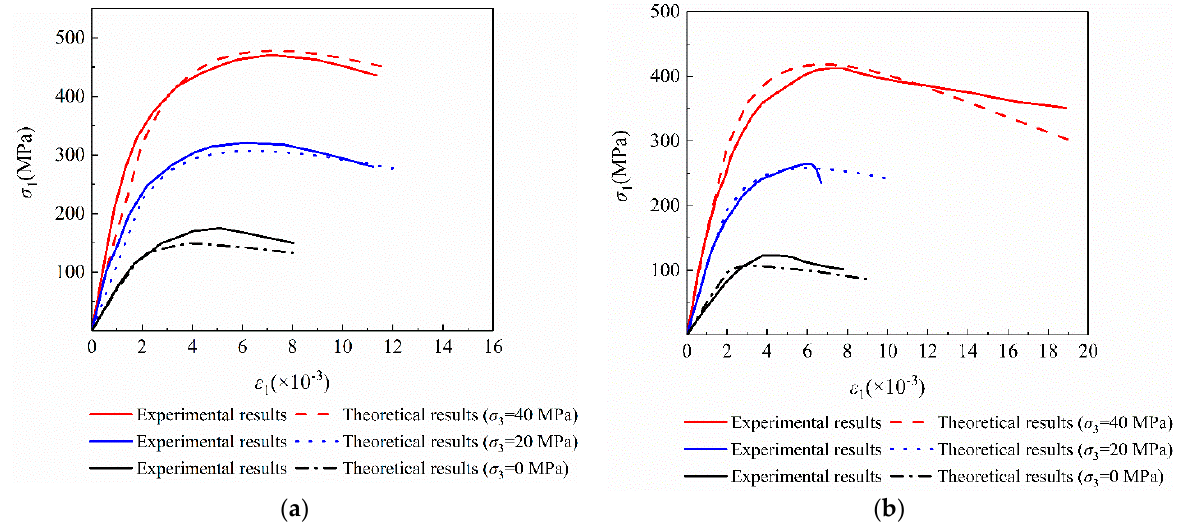
Figure 10. Comparison of theoretical and experimental stress-strain curves under different confining pressures. ( a ) Theoretical and experimental stress-strain curves of granite. ( b ) Theoretical and experimental stress-strain curves of Jinping marble.